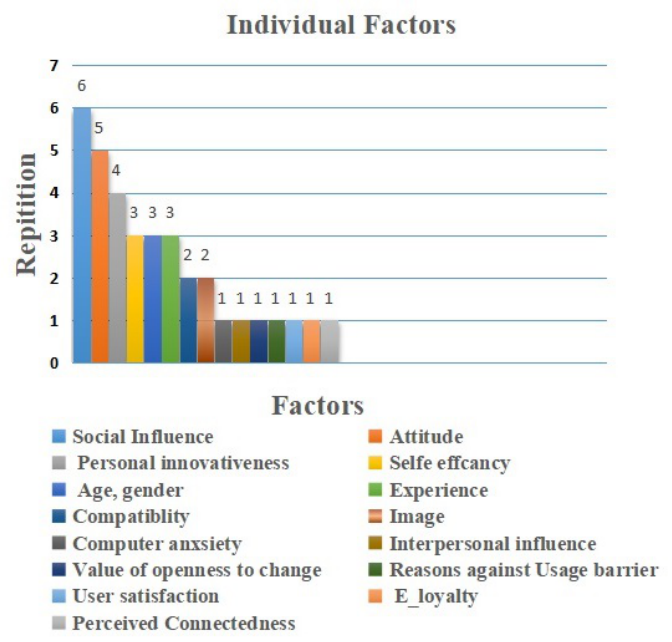
Figure 7. Individual